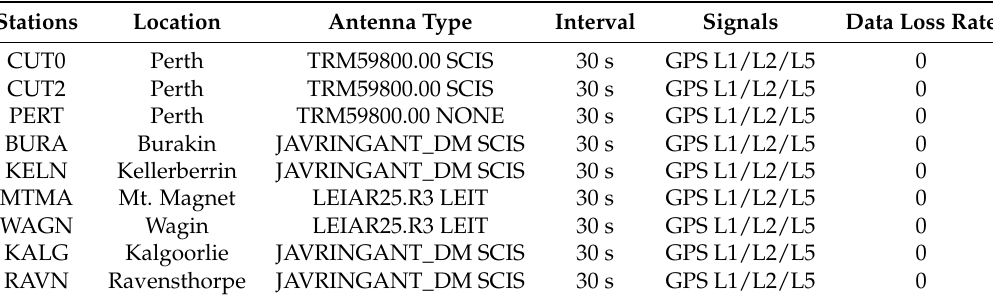
Table 6. Information of the stations and the